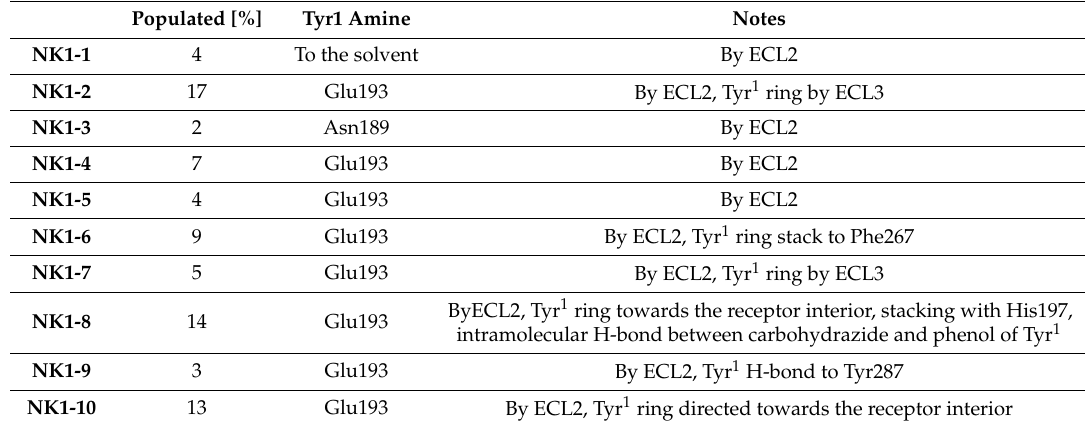
Table 6. Description of representative structures for clusters related to Tyr- d -Ala-Gly-Phe-fragment position in